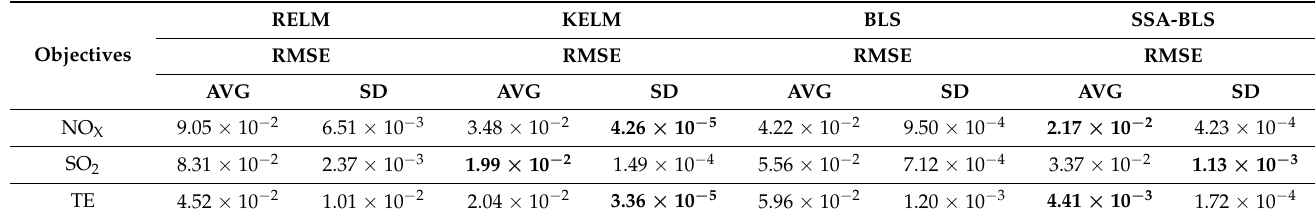
Table 9. The RMSE of the four algorithms on the training set of boiler data.